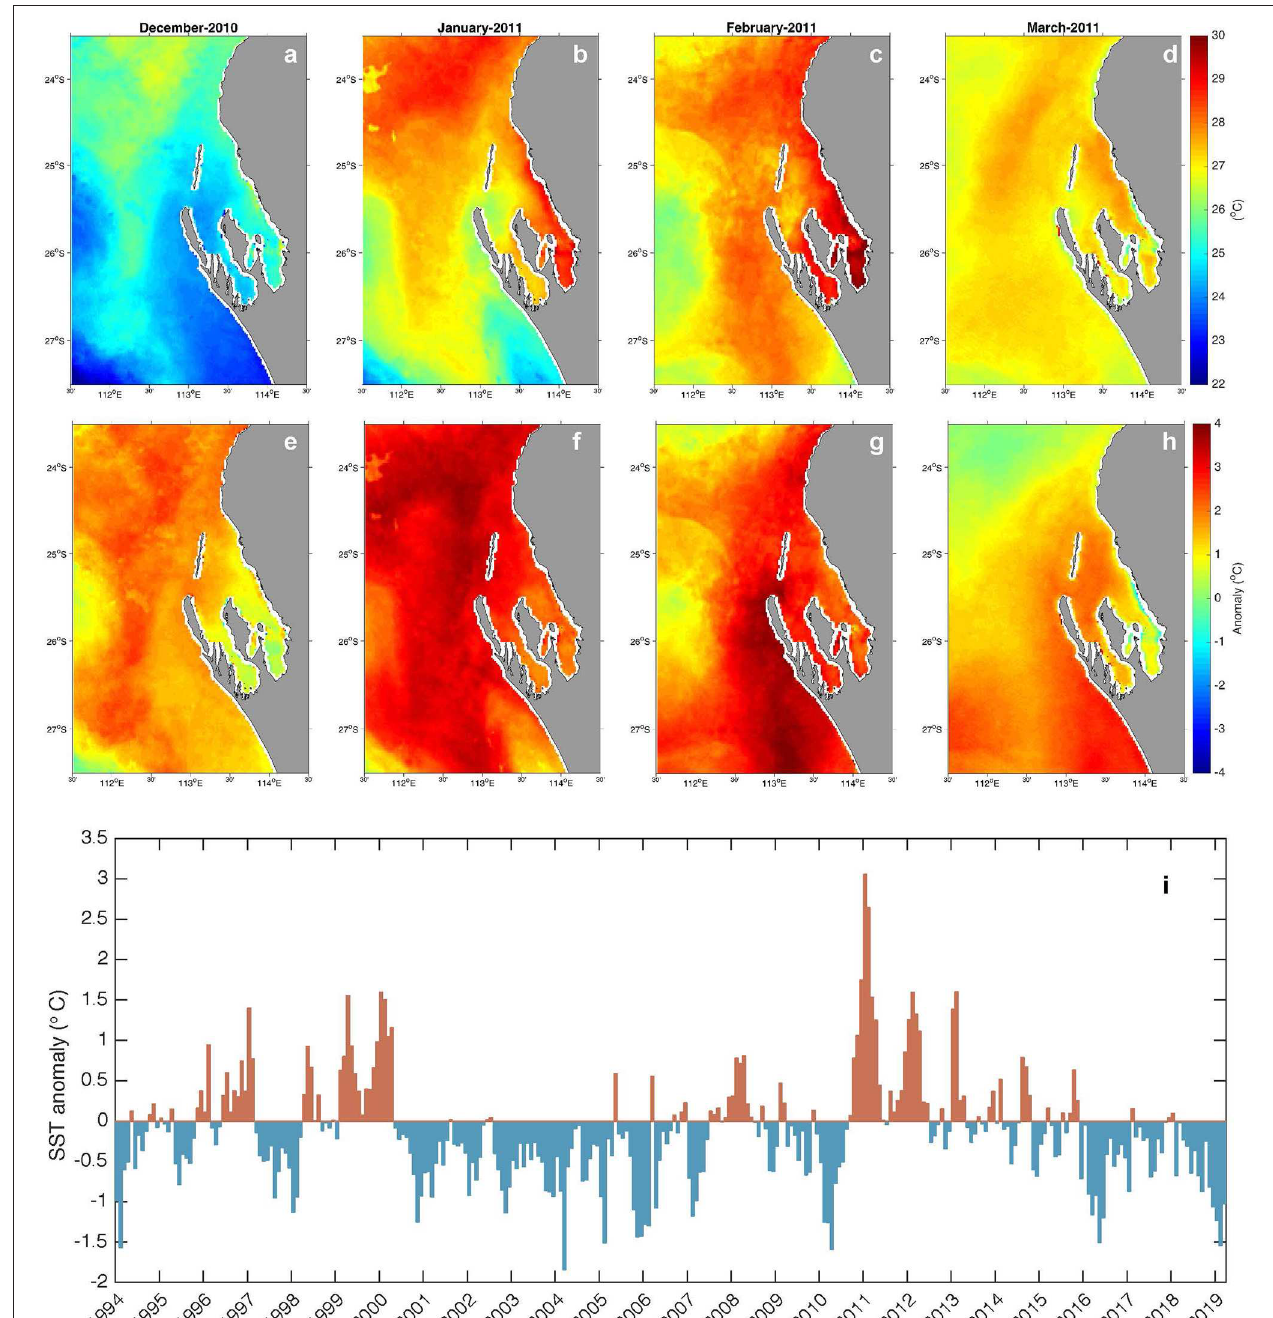
FIGURE 2 | Monthly mean satellite SST (a–d) and anomalies (e–h) calculated from the SSTAARS 1993–2016 climatology (Wijffels et al., 2018) for the 2011 MHW event. Interesting features visible in the images include: intrusion of cooler upwelled water into the bay (a) and subsequent shut down of this cooling mechanism during February (g) ; spatial variability of MHW signature in shallow areas of the inner bay (higher temperatures, faster cooling (c,h) . Time series of the mean anomaly over the map domain is shown in (i) , highlighting the elevated temperatures related to La Niña in 1999–2000 and 2010–2012.